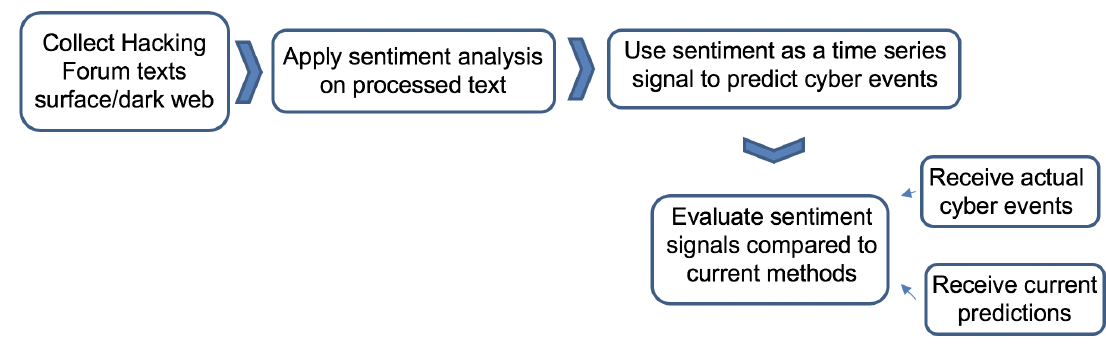
Figure 2. Overview of the